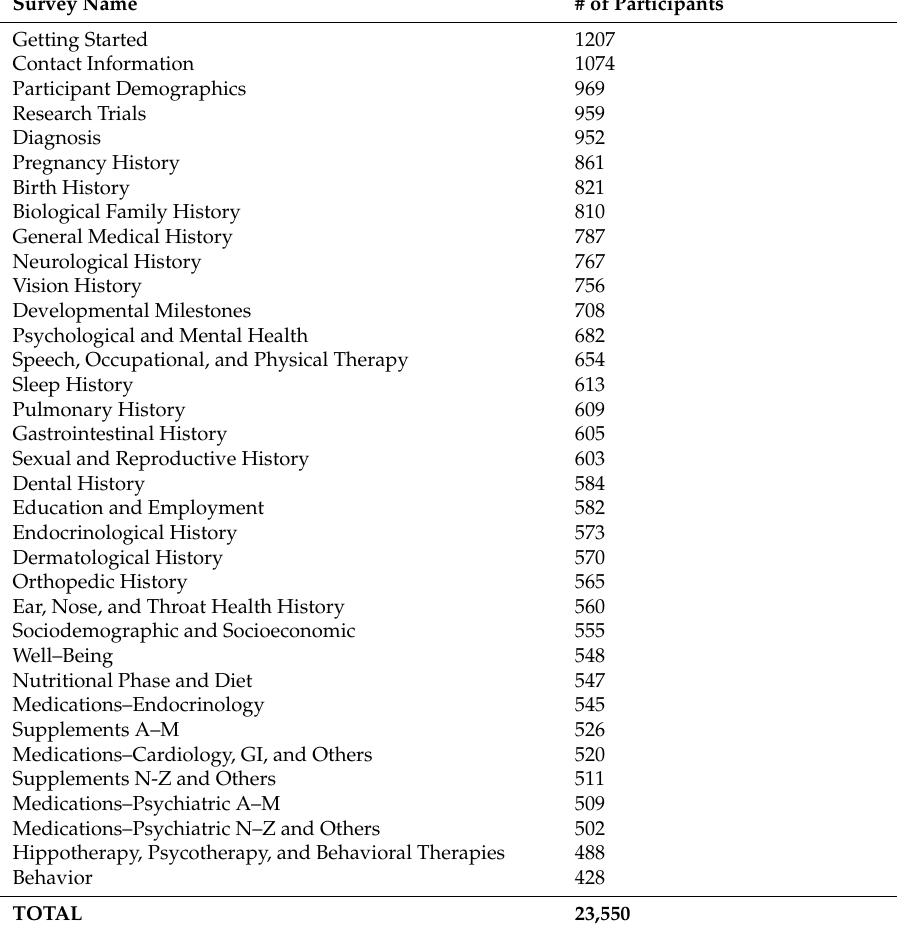
Table 1. Surveys included in the Global Prader–Willi syndrome (PWS) Registry launch, and the number of submissions per survey. The initial launch of the PWS Registry included 35 surveys. Surveys have been completed by varying numbers of